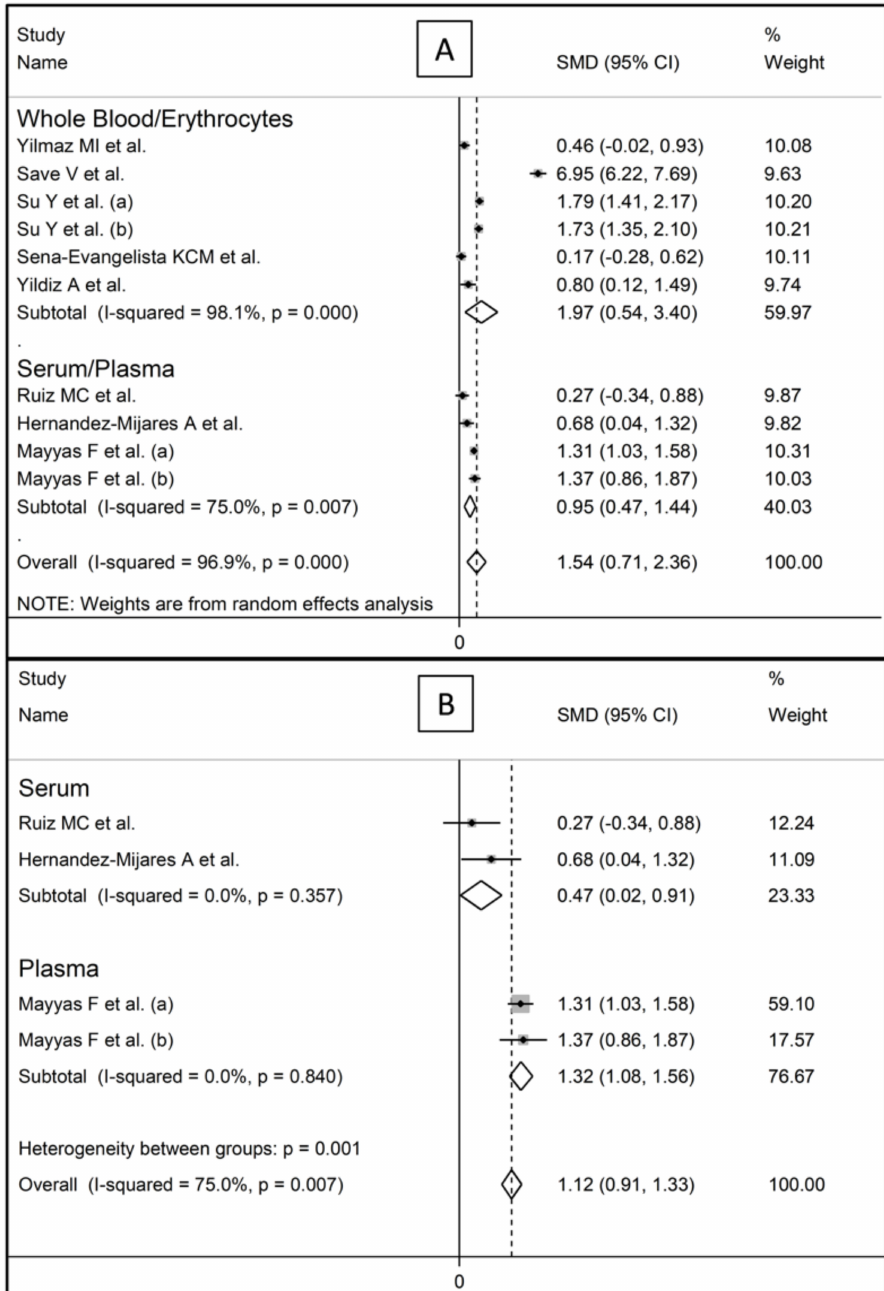
Figure 8B) and those assessing serum (SMD = 0.47, 95% CI 0.02 to 0.91, p = 0.038). In both cases, however, no heterogeneity was observed (I 2 = 0.0%). The SMD with individual